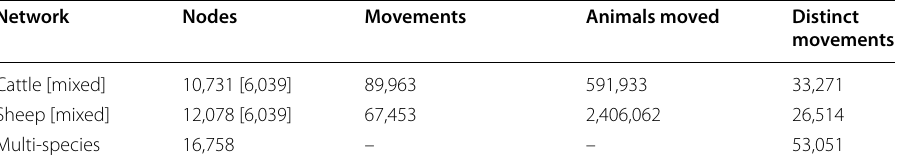
The number of nodes describe the total number of farms raising cattle or sheep reporting at least one animal movement during 2016. The number of movements (batches), the total number of animal moved per species, as well as the headcount of cattle and sheep in Scotland are shown. The number of distinct movements correspond to the number of unique pair of origin and destination in each network